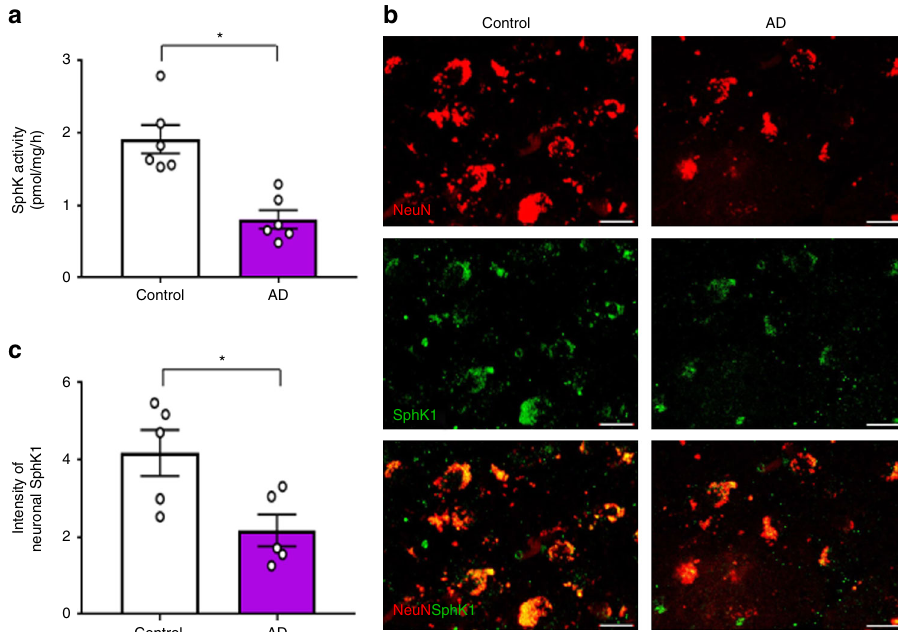
Fig. 6 SphK1 is decreased in AD patient brains and neurons. a Characterization of SphK activity in cortex brain samples from AD and control human subjects ( n = 6 per group). b Representative immuno fl uorescence images of cortex brain samples from AD and control human subjects showing SphK1 (green) merged with neuron (NeuN, red). Scale bars, 20 μ m. c Quanti fi cation of neuronal SphK1 ( n = 5 per group). a , c Student ’ s t test. * P < 0.05. All error bars indicate